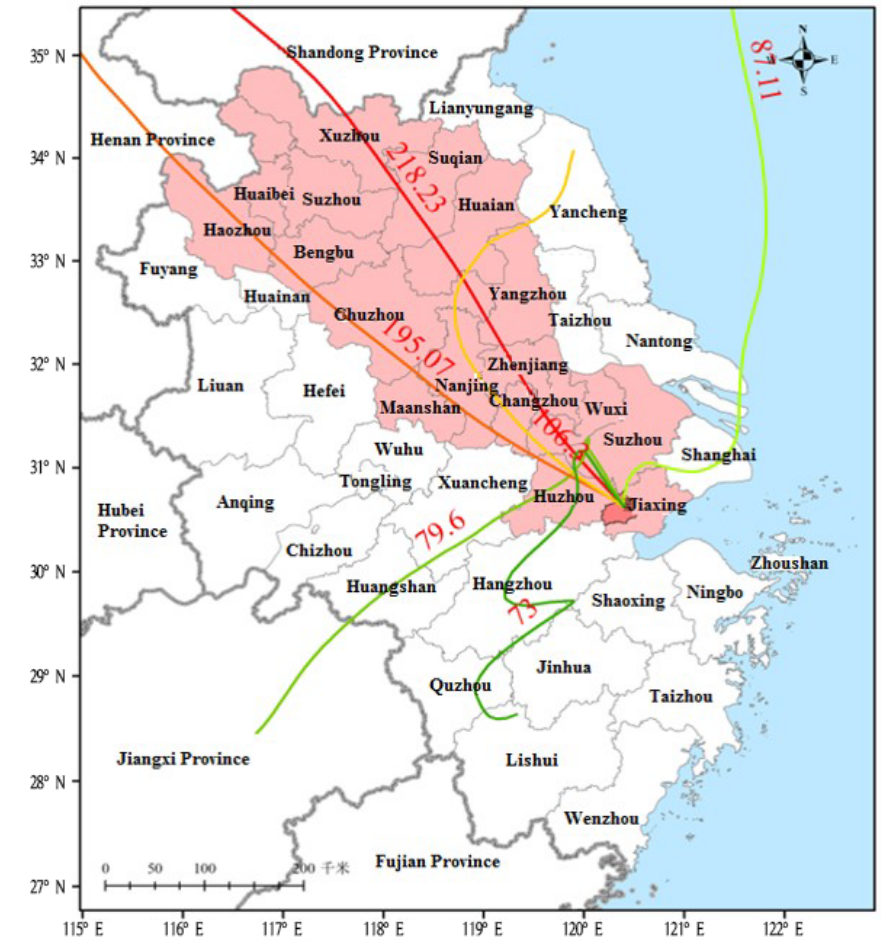
Figure 17. Cities involved in the transport channel and the emission reduction